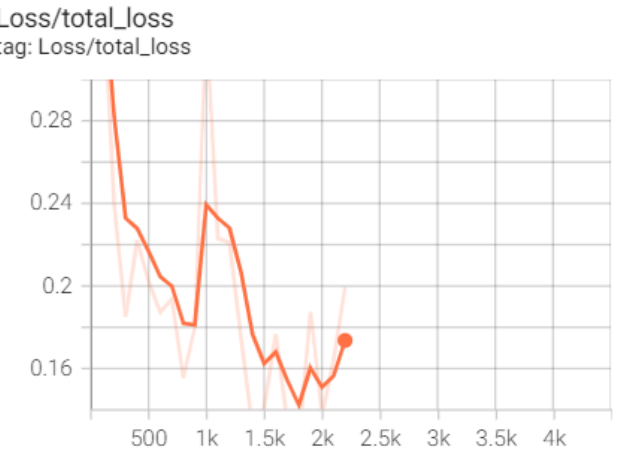
Figure 19. Evolution of the loss function during training.